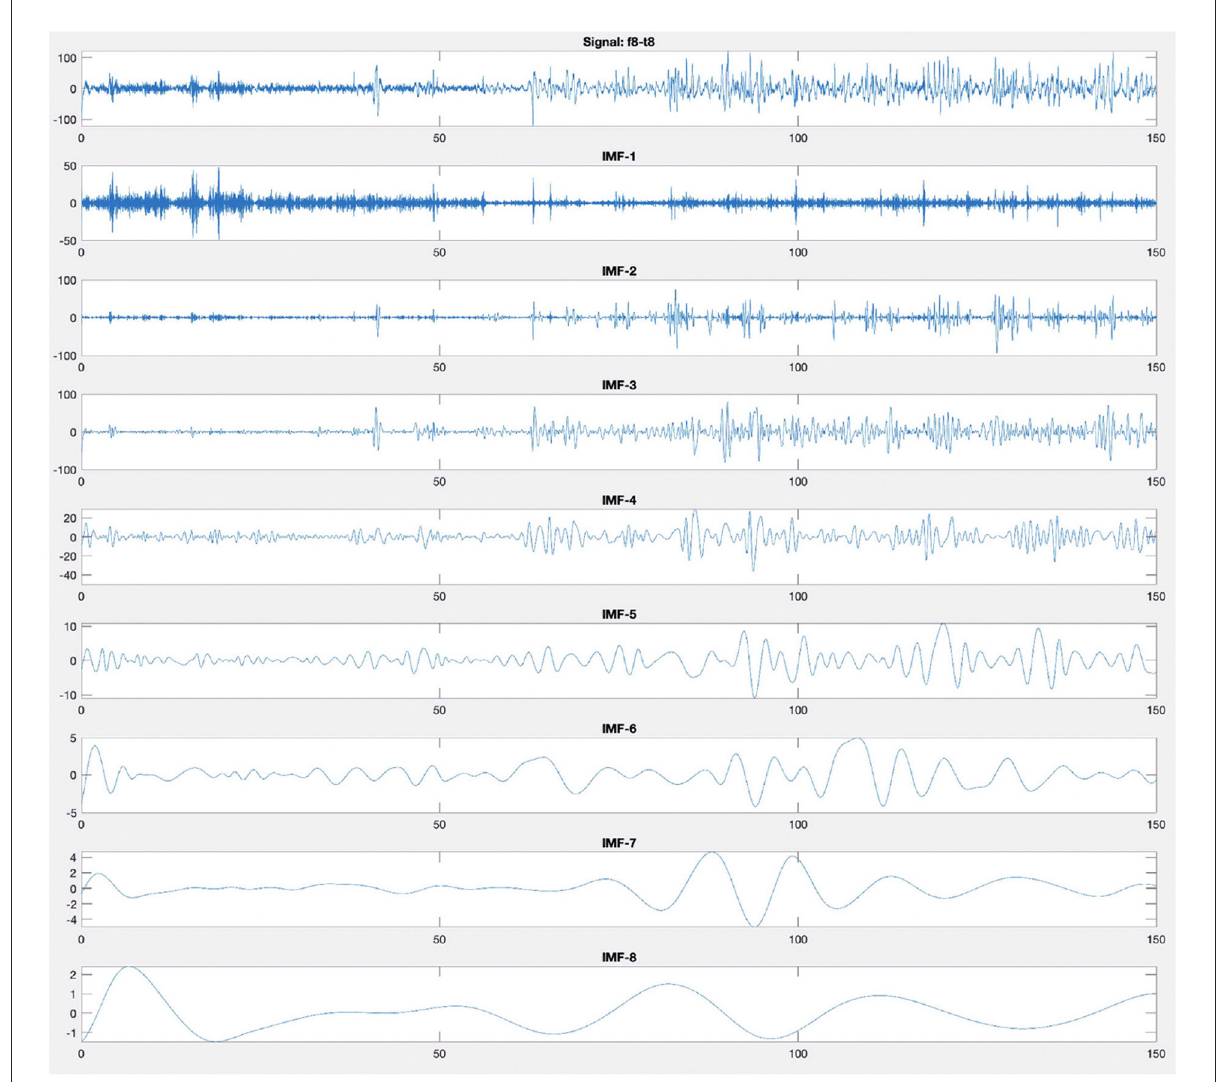
FIGURE4 Empirical mode decomposition components of an EEG signal. The first time series is the original EEG recording from F8–T8 channel. The decomposition yields eight IMFs. The IMF are the time frequency constituents or components of the EEG signal. Frequency content is ordered in a descending order (IMF-1 has the highest frequency